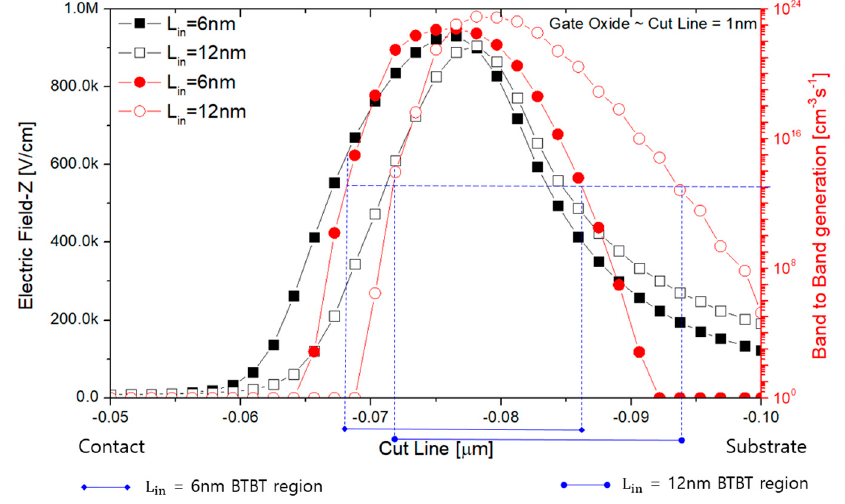
Figure 9. Electric field-Z and band-to-band generation according to L in = 6 nm and 12 nm of Pi-BCAT.